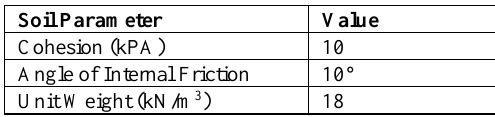
Table 1 . Soil Parameters.